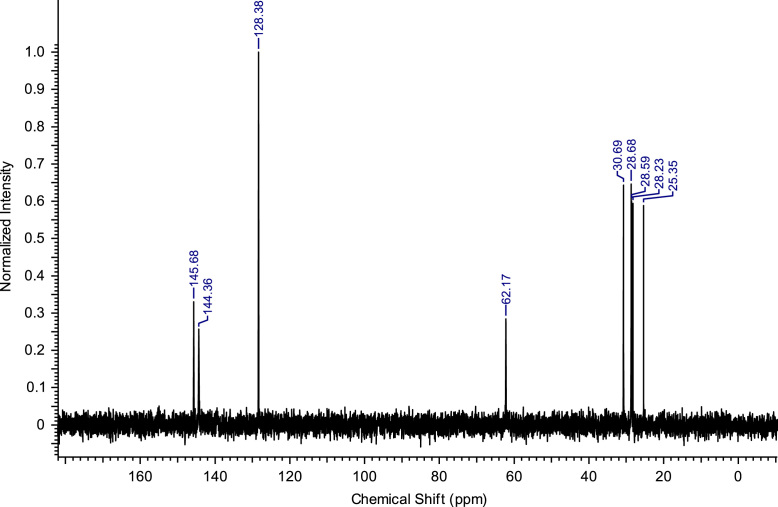
13C NMR spectra of C12(Pyr)2Br2.